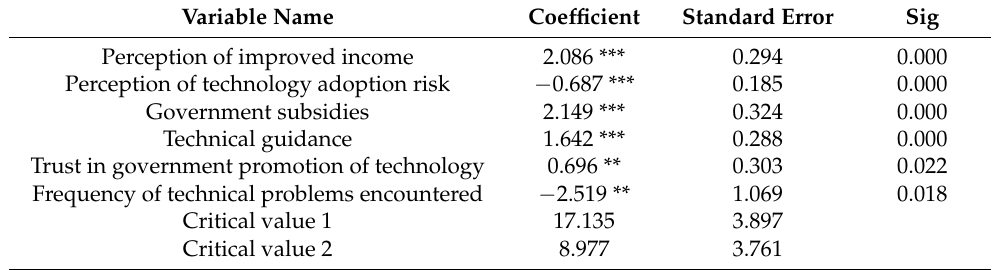
Table 6. Estimation result of farmers’ willingness to adopt light trapping